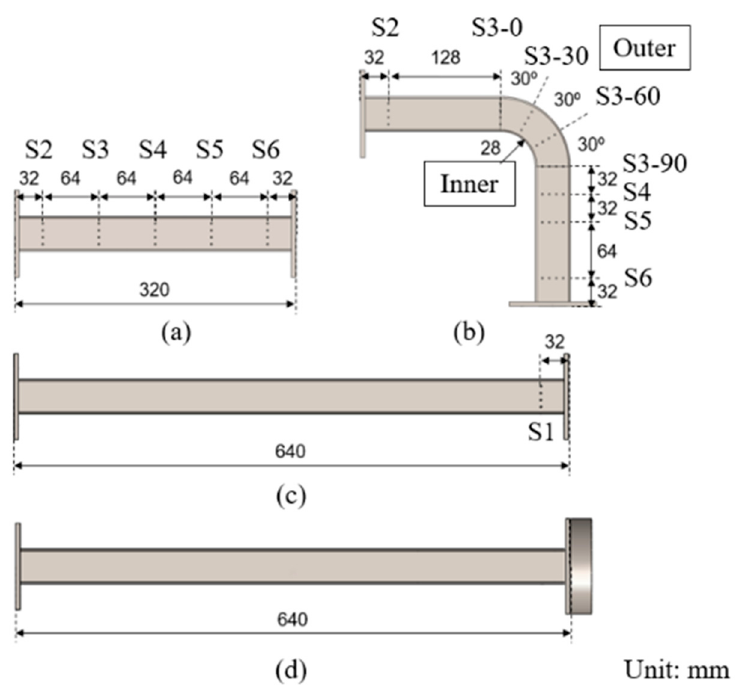
Figure 2. Schematic diagram of measurement points on pipes (top view): ( a ) straight pipe; ( b ) curved pipe; ( c ) upstream pipe; ( d ) downstream pipe.